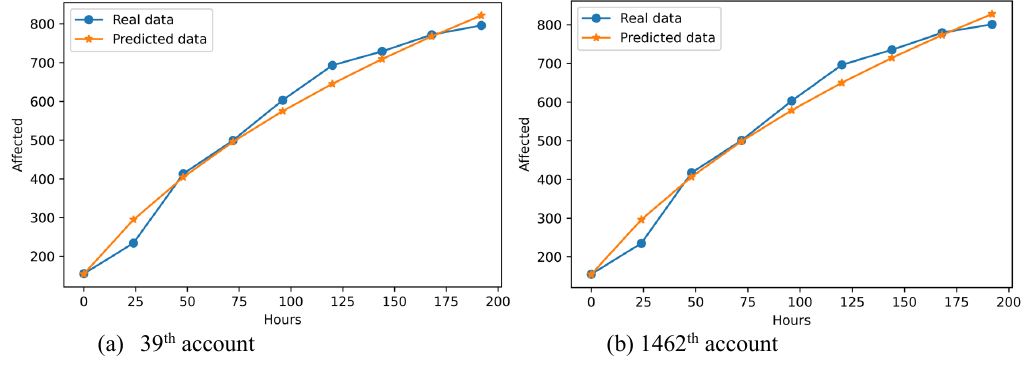
as (cid:3036)(cid:3043)